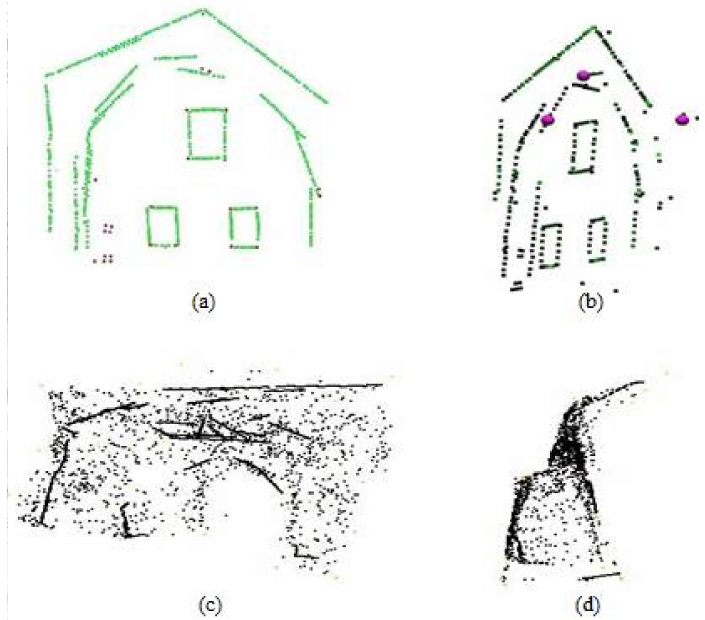
Figure 6. Initial 3D point cloud of the Neoria building, front façade: ( a ) point cloud formed by the points of line segments; ( b ) enhanced point cloud with the georeferenced points from the tacheometric measurements. The purple dots indicate 3D points augmented with depth information. Right façade: ( c , d ) enriched point cloud including the points of line segments, the georeferenced coordinates along with the interpolated points used for demonstrative